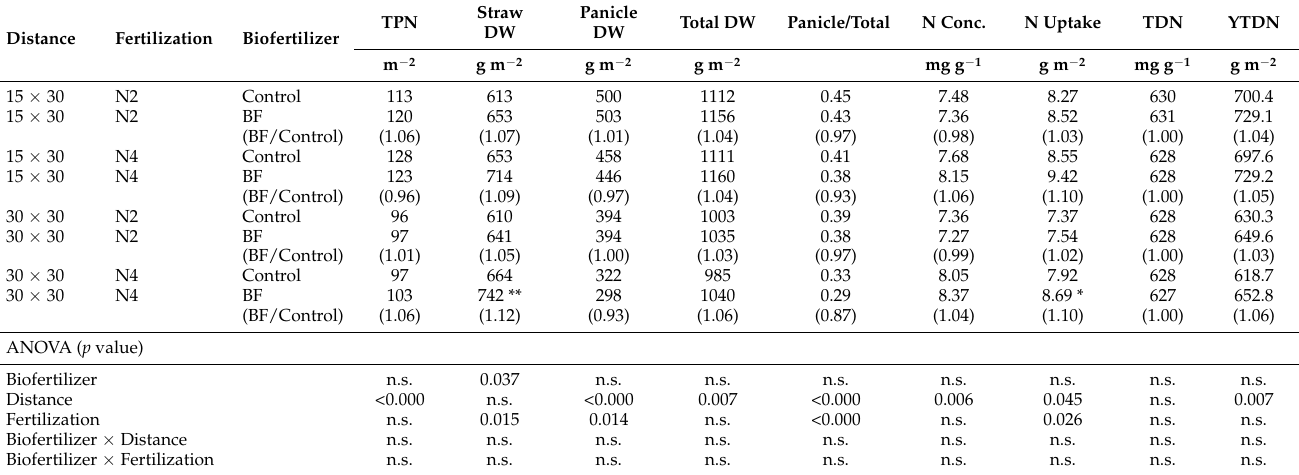
Table 4. Yield components for whole crop silage rice ( Oryza sativa L. line